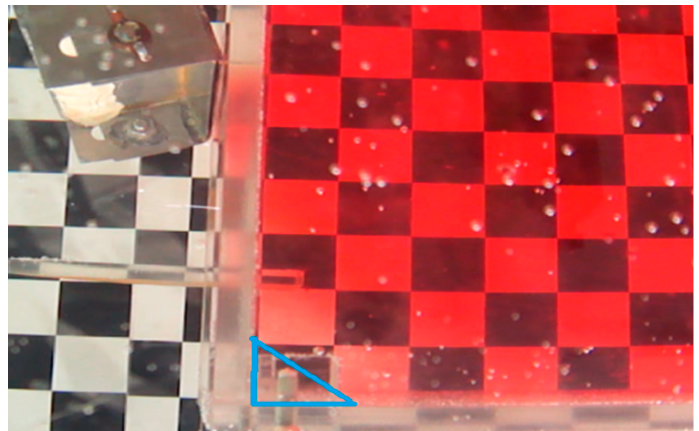
Figure 4. Oversized exhaust flow rate.